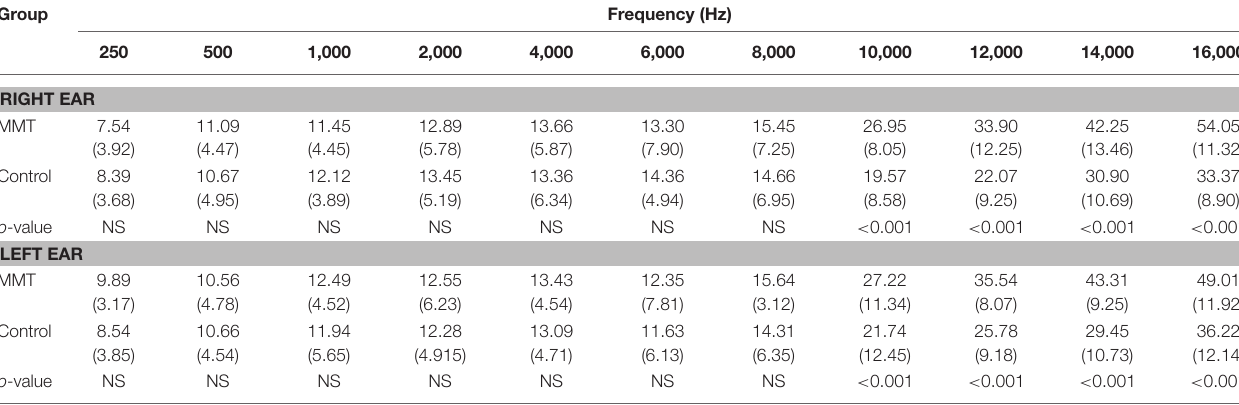
TABLE 1 | Hearing thresholds in normal controls vs. patients underwent methadone maintenance treatment (MMT). Group